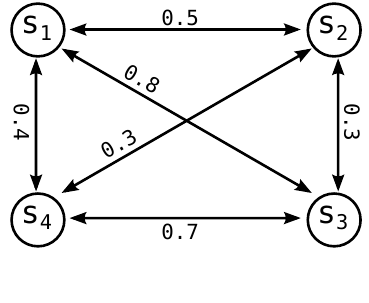
Figure 4. An example instance of the semantic similarity graph